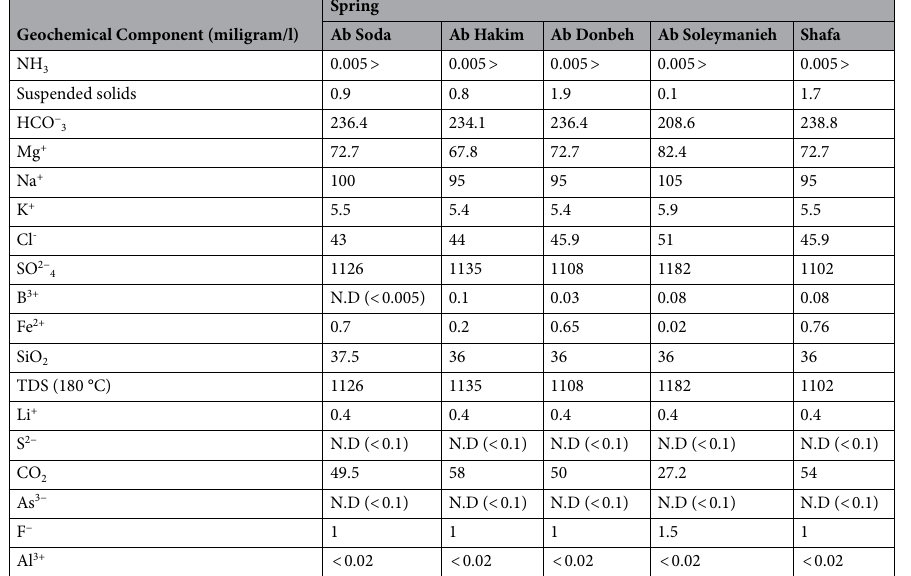
Table 2. Results of geochemical analyses in Mahallat